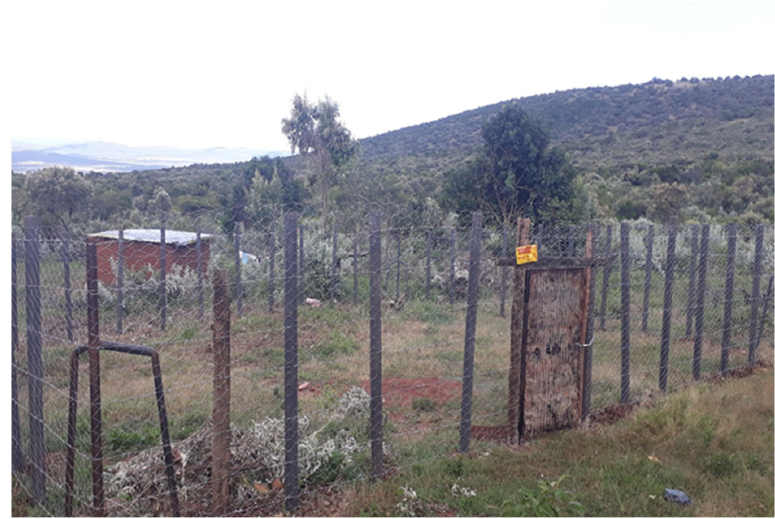
FigureA3: Predator ‐ Proof Boma/Kraal. Figure A3. Predator-Proof Boma/Kraal.